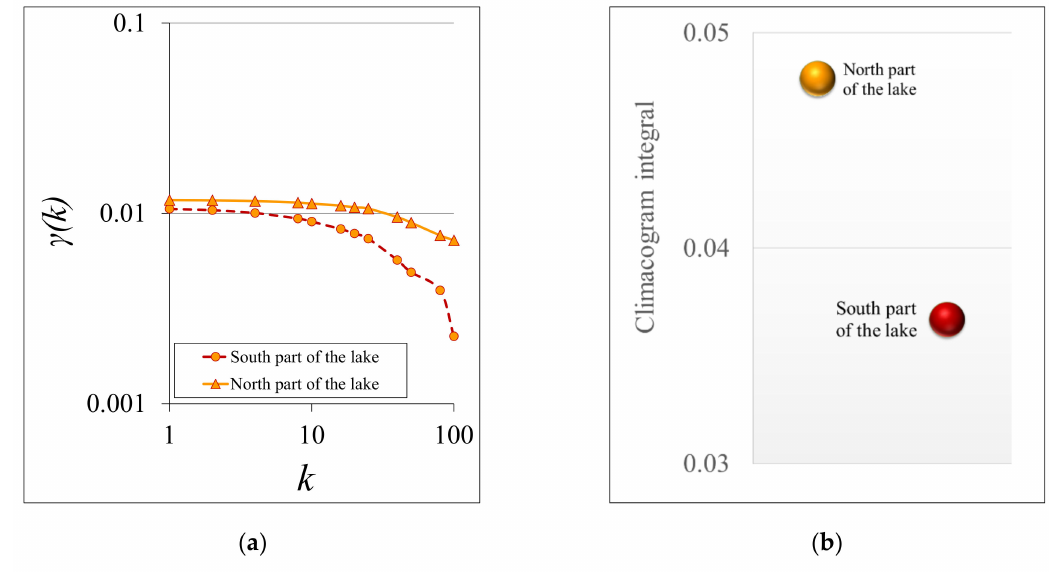
Figure 12. ( a ) Climacogram for each scale of Figure 9b,c; ( b ) rate of alteration of clustering of Figure 9b,c.